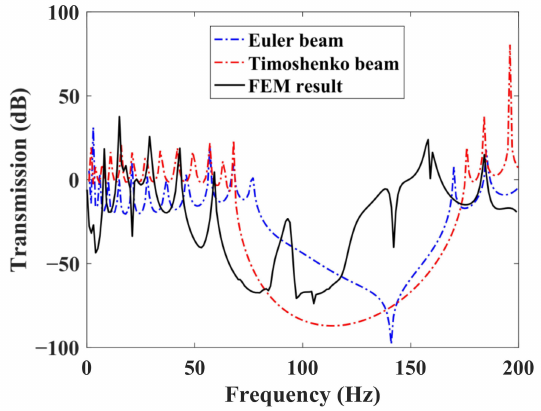
Figure 12. The transmission response curves calculated by SEM and